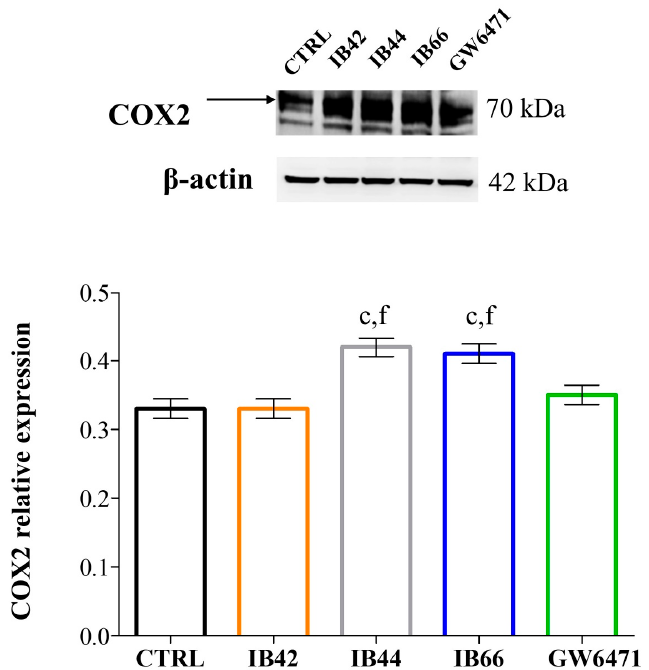
Figure 7. COX2 expression levels. Western blot analysis of COX2 in the presence of compounds at 3 µ M for 24 h. β -actin is used as loading control. The bar graph shows densitometric values related to COX2 expressed as mean densitometric measurements ± S.D. (n = 3) normalized on the ones of the loading control. CTRL = untreated control. c ( p < 0.0001) between untreated cultures and treated samples. f ( p < 0.0001) between GW6471-treated cultures and samples in the presence of phenylsulfonimide derivatives.